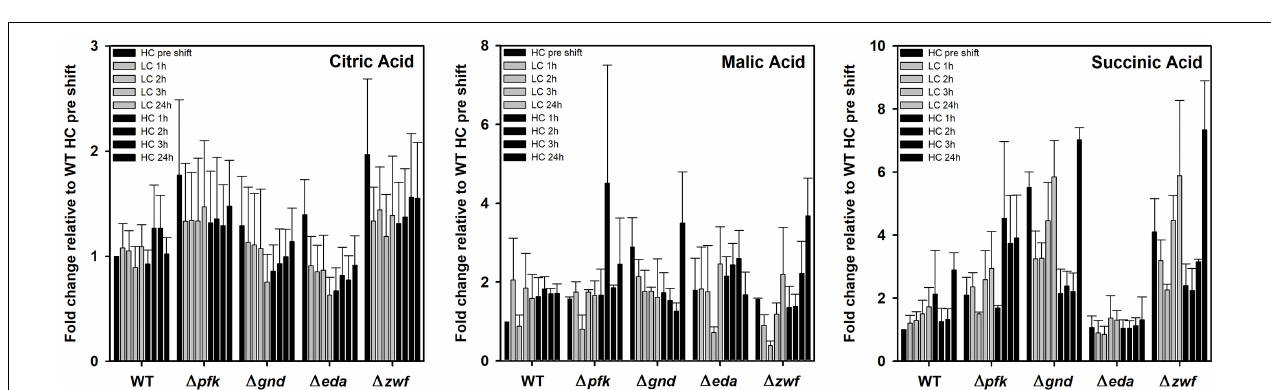
FIGURE 6 | Changes in RubisCO reaction products in different strains during HC-LC-HC shifts. Alterations in the contents of 3-phosphoglycerate and 2-phosphoglycolate are given as fold changes relative to wild-type values (WT, HC pre shift was set to 1) under HC conditions at the beginning of the HC-LC-HC shift experiment. Mean values and standard deviations of fold changes are displayed from all three independent experiments.